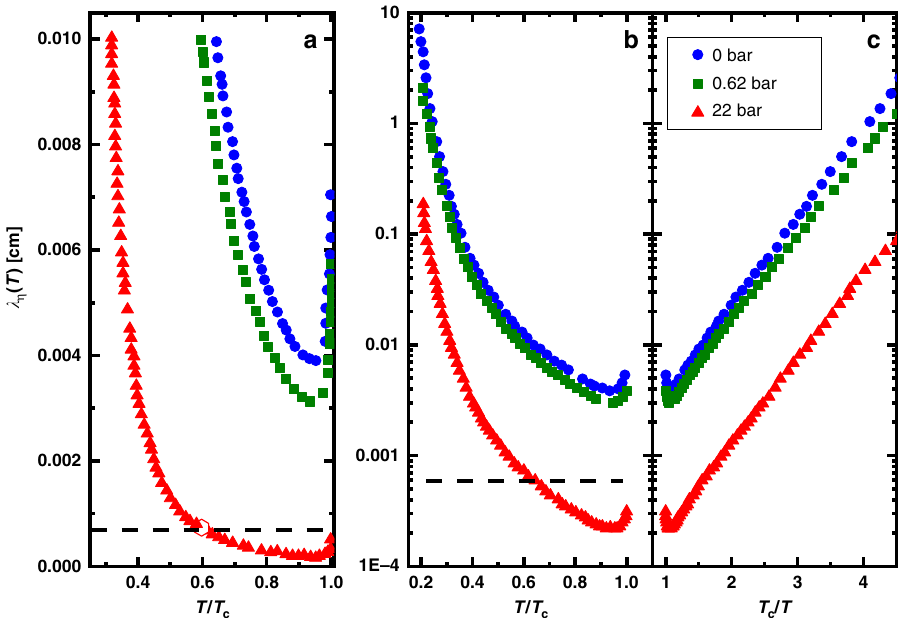
Fig. 8 Viscous mean free path in super fl uid state. a The viscous mean free path, λ η below T c as a function of T / T c and T c / T for 0 (blue circles), 0.62 (green squares), and 22 (red triangles) bar pressures. Note the strong increase in λ η from a minimum just below T c . b , c The viscous mean free path in cm on a logarithmic scale. At 0.6 T / T c for 22 bar, the mean free path is ~6 μ m (dashed